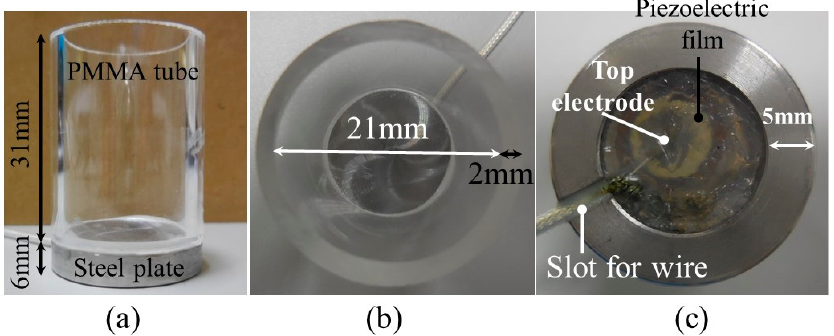
Figure 2. Photographs of the designed apparatus from ( a ) the side, ( b ) the top and ( c ) the bottom